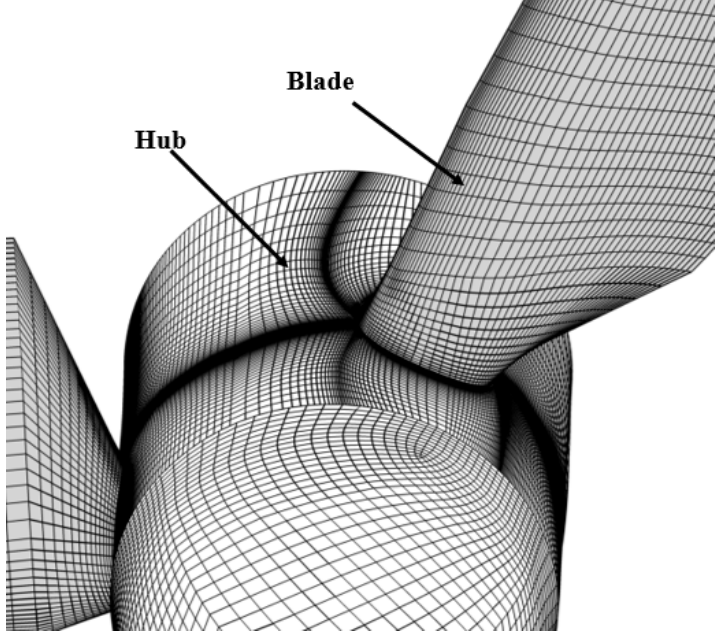
Figure 5. Detail of the hub and blade surface mesh. The blocks representing the inlet and outlet regions were structured while the block near the hub nose region employed an unstructured grid. The surface of the blade was meshed with 132 cells in the chord-wise direction: the cells were concentrated at the leading and trailing edge, while 162 cells were distributed in the span-wise direction. Since a thin boundary layer is present near the blade, a grid refinement was added in the normal direction: the inflation layer had 16 rows, where the first row height was 0.01 mm from the blade wall and the growth factor of the grid was 1.25. This leads to a y + on the pressure side, suction side and tip of the blade of less than 4 and increases at the nose region to about 6, as illustrated in Figure